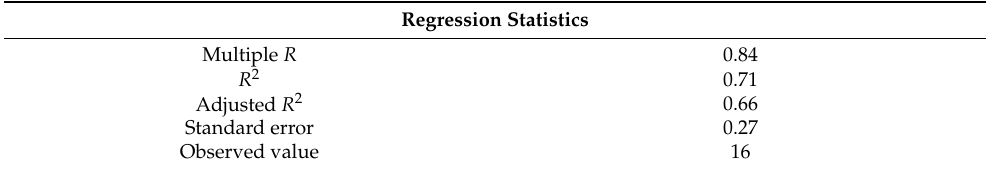
Table 8. Regression statistics.